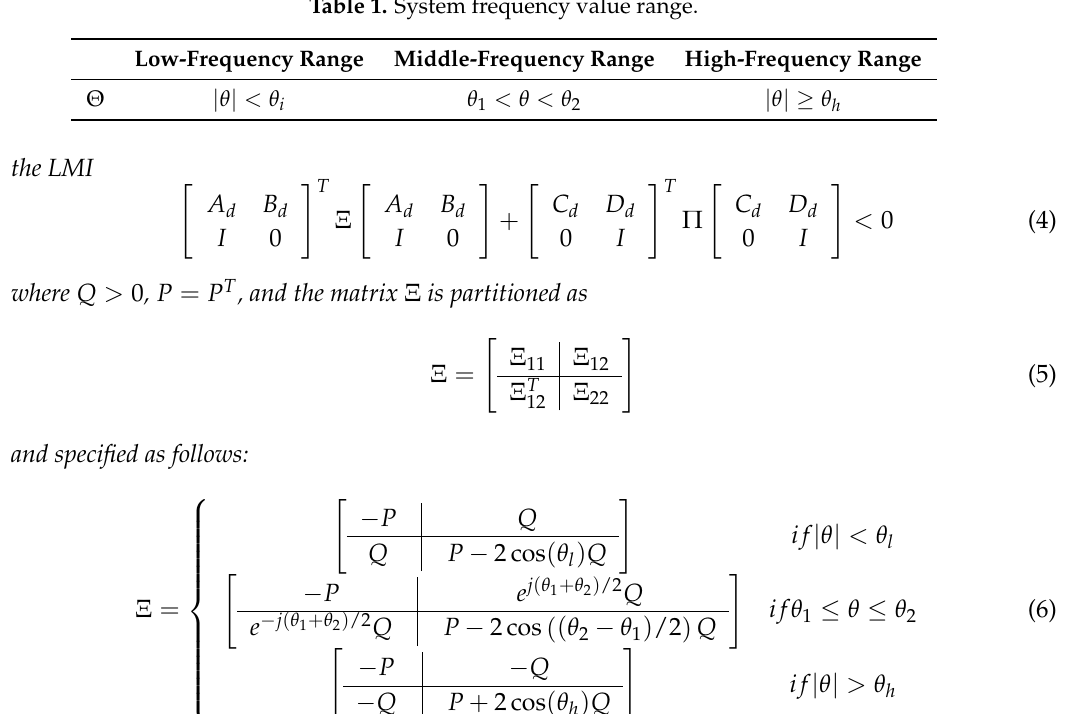
Table 1. System frequency value